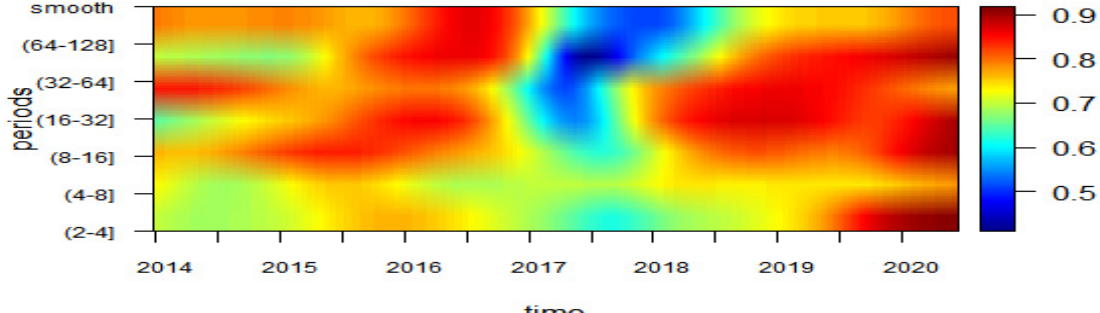
as indicated by the wavelet power of pairwise analysis analysed in the lower scale brackets. Put differently, the co-movements (either positive or negative) seem to have been stronger during the COVID-19 pandemic in most of the series under consideration. Specifically, with the notable exception of Japan, the financial markets under considera- tion showed significant dominant signs of co-movement at periods of high frequency up to 64 days in length. In the case of the UK–Canada correlation, the market contagion appears even stronger, as indicated by the red colour in Figures 1 and 5. The results of the wavelet analysis in Figures 1–5 reveal a degree of co-movement between the U.S. and other financial markets, suggesting that a parametric analysis may reveal more insights into the contagion effects during the COVID-19 outbreak. 4.2. WC-GARCH Procedure Estimation Results Once the filtered series were extracted in the second step of our analysis, appropri- ate univariate GARCH models were estimated for the six stochastic processes under consideration. Comparing a number of GARCH-type models, we concluded that a GJR-GARCH model with a GHD distribution for the innovation terms was the specifica- tion that best fit the data under consideration. To investigate the effects of the COVID-19 pandemic, the sample under consideration was split into two subperiods: the first with (cid:1846) = 1465 including data from 2 January 2014 to 29 November 2019; and the second subperiod with a sample of (cid:1846) = 172 including observations from 2 December 2019 to 8 August 2020. The WC-GARCH procedure suggested in Section 3 involves estimating a total of (cid:3435)6 × (cid:1830) (cid:3037) (cid:3439) = 36 GARCH-GJR (1,1) models for each subperiod, generating a staggering to- tal of 72 models to be estimated. To save space, the estimation results are not reported here, but they are available upon request. However, to give an idea of the magnitude of the estimated coefficients for the conditional variance equations, the estimation results for the marginal distributions for the six stock markets under consideration in the two subperiods are reported in Tables 1 and 2. Tables 1 and 2 present the GARCH-GJR (1,1) parameter estimates for models esti- mated for the period before and during the COVID-19 outbreak, respectively. From Ta- ble 2, it appears that stock market indices are highly persistent, since the magnitude of the estimated parameters (cid:2010) is relatively high for all of the estimated series. In Tables 1 and 2, bad news also appears to impact stock market volatility, since all of the estimated (cid:2011) values significantly differ from zero. Furthermore, the diagnostic tests included at the